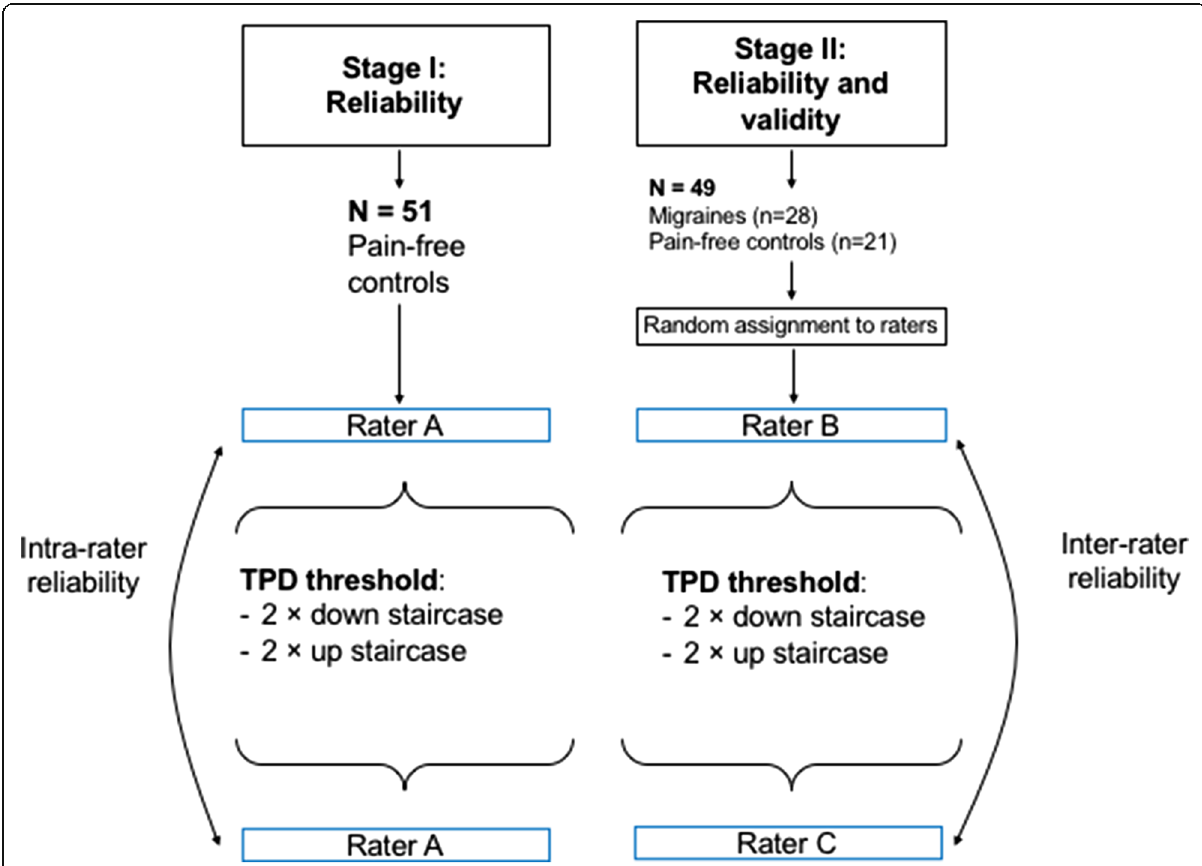
Fig. 1 Study design. Intra-rater reliability was assessed in the first stage (left) while inter-rater and differences between migraines and controls in the second stage of the study. TPD - Two-point discrimination